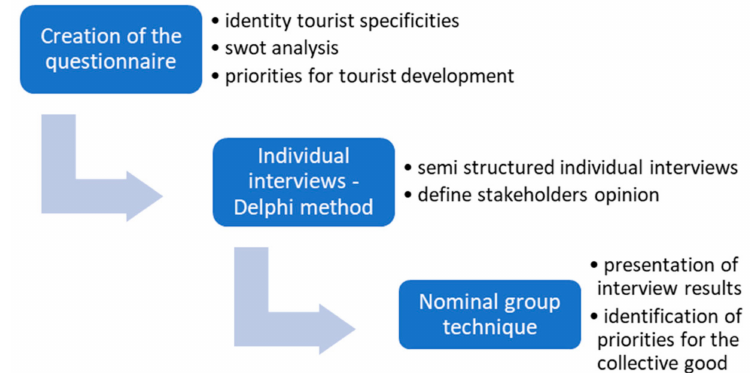
Figure 3. Identification of the three steps related to research